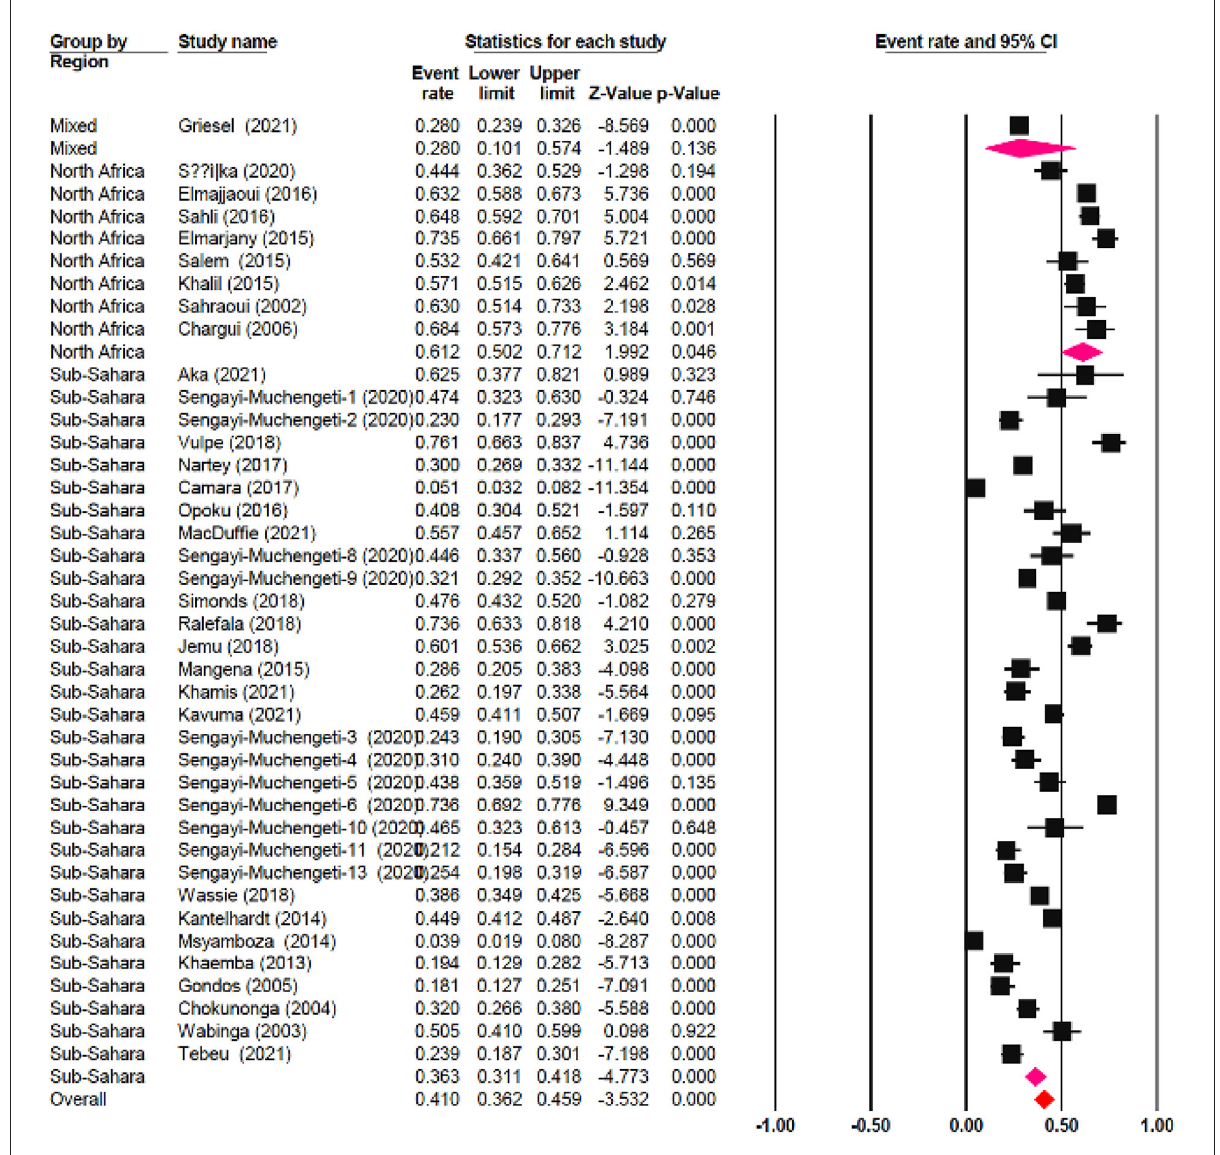
FIGURE7 Forest plot on racial